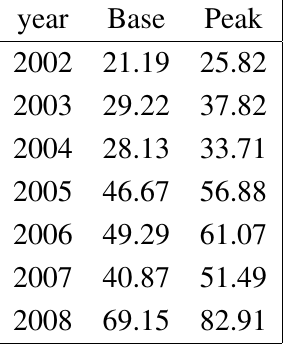
Table 2. Average prices of French electricity.